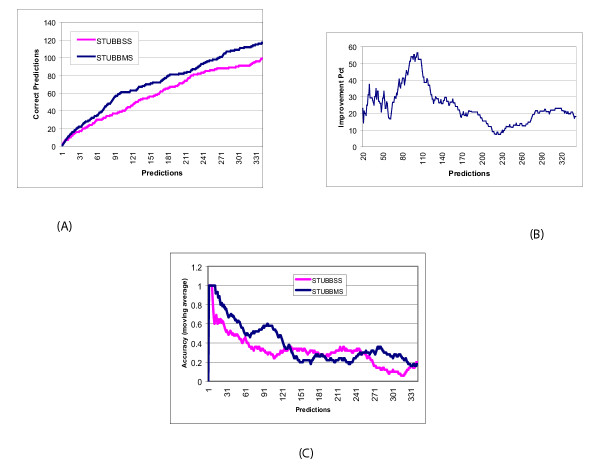
(a) Effect of two-species data on performance. The x-axis is the number of unique genes predicted to be ap patterned in the blastoderm, restricted to those for which we have expression information. The y-axis is the number of predictions that are actually blastoderm patterned. STUBBSS and STUBBMS represent the single-species and two-species Stubb runs respectively. (b) The increase in number of correct predictions from STUBBSS to STUBBMS, as a percentage of the correct predictions made by STUBBSS. (c) The specificity values for a moving window of 50 predictions. The y-axis is the number of correct predictions as a fraction of the number of predictions, which is 50 for each window.